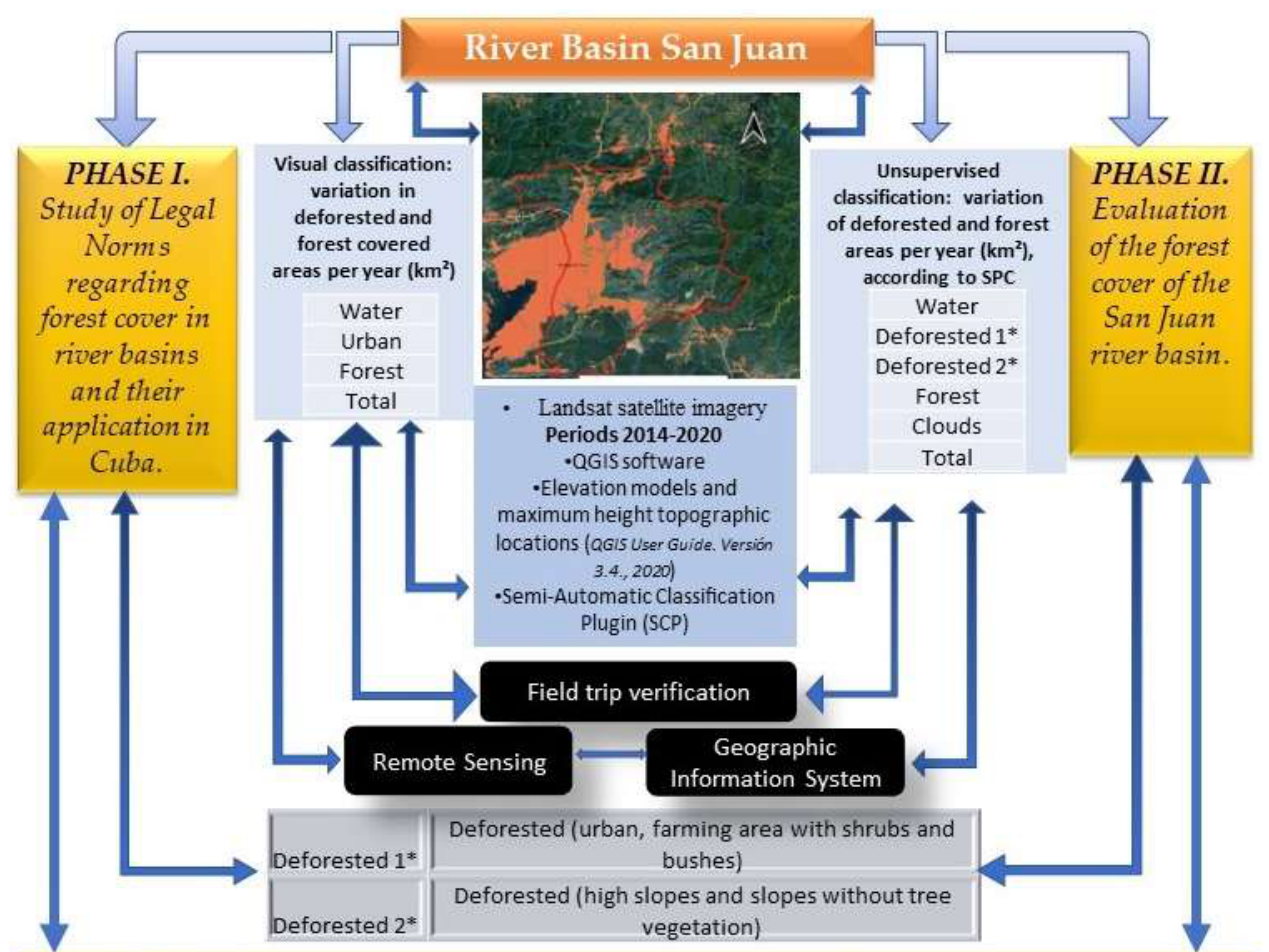
Figure 2. Methodological framework of this research.